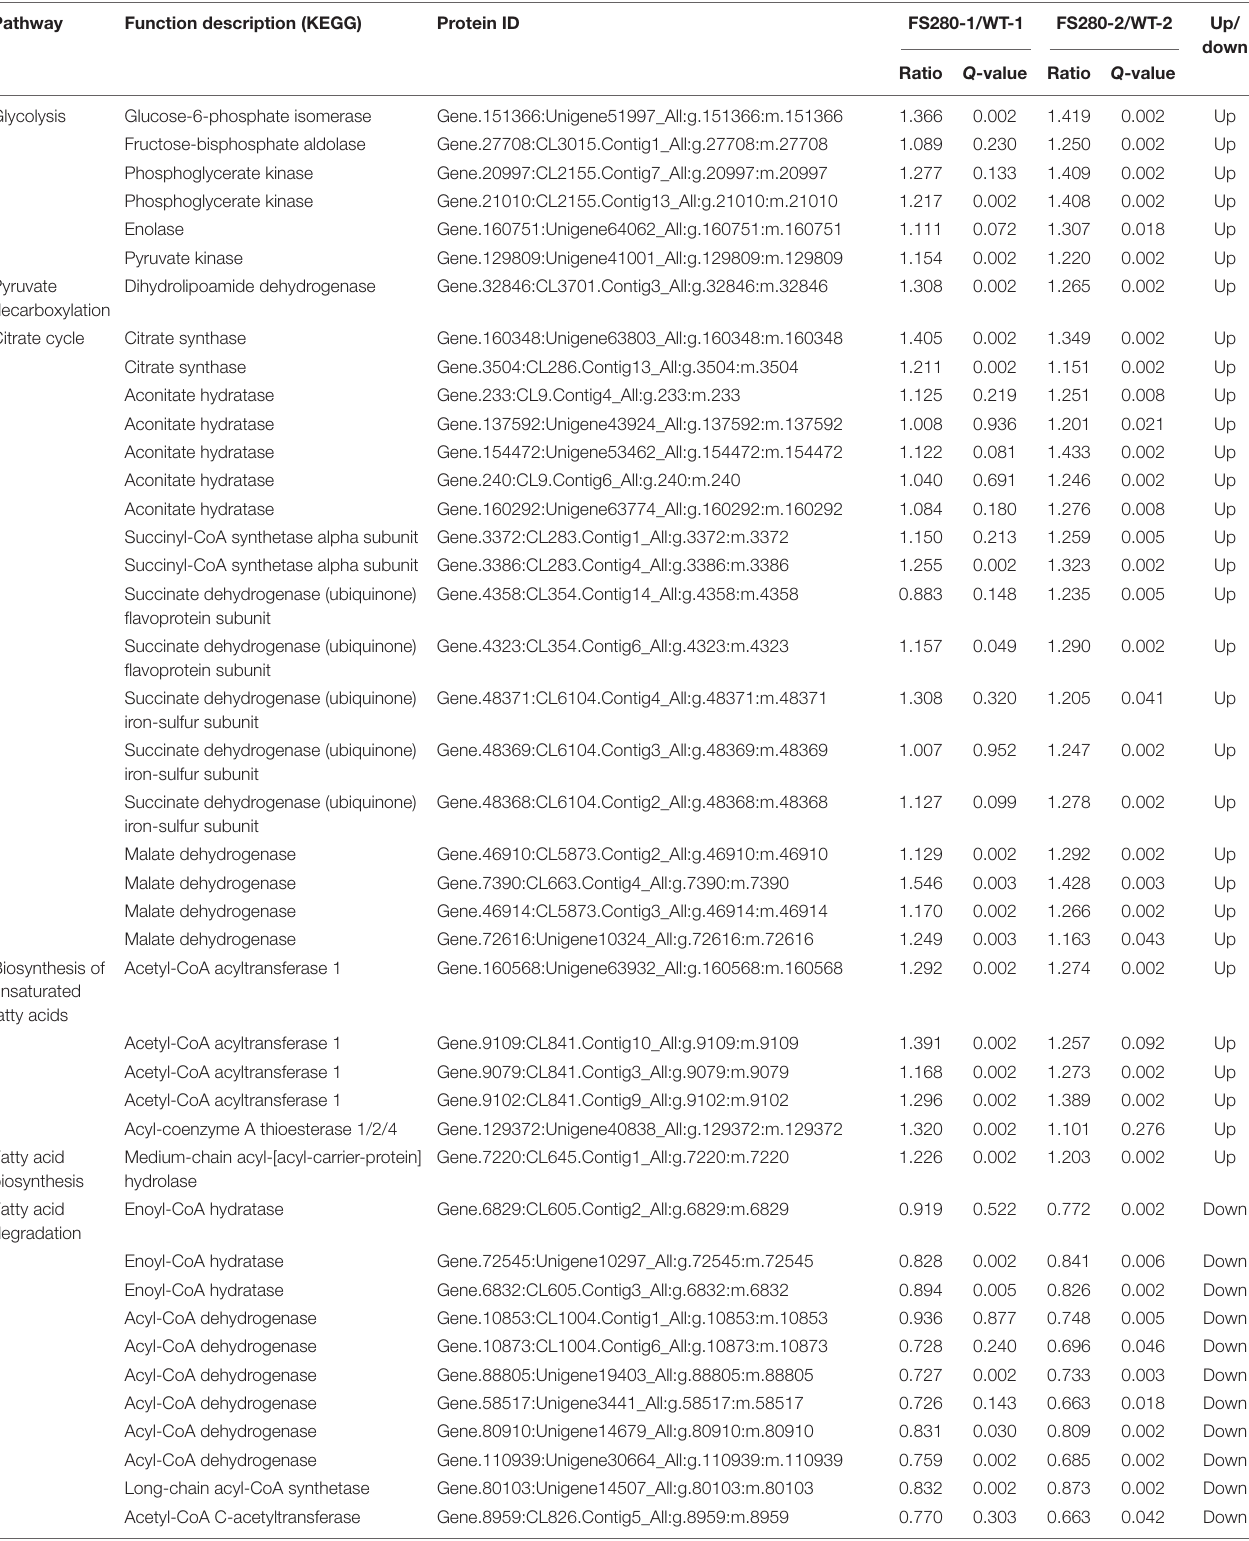
TABLE 1 | Differentially expressed proteins related to biosynthesis pathways in FS280 vs. WT. Pathway Function description